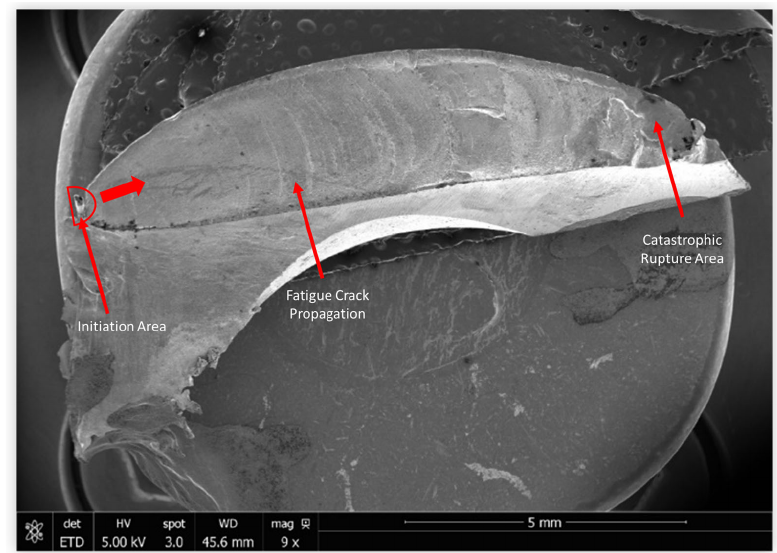
Figure 10. The failure surface showing crack initiation, propagation, and final failure areas.